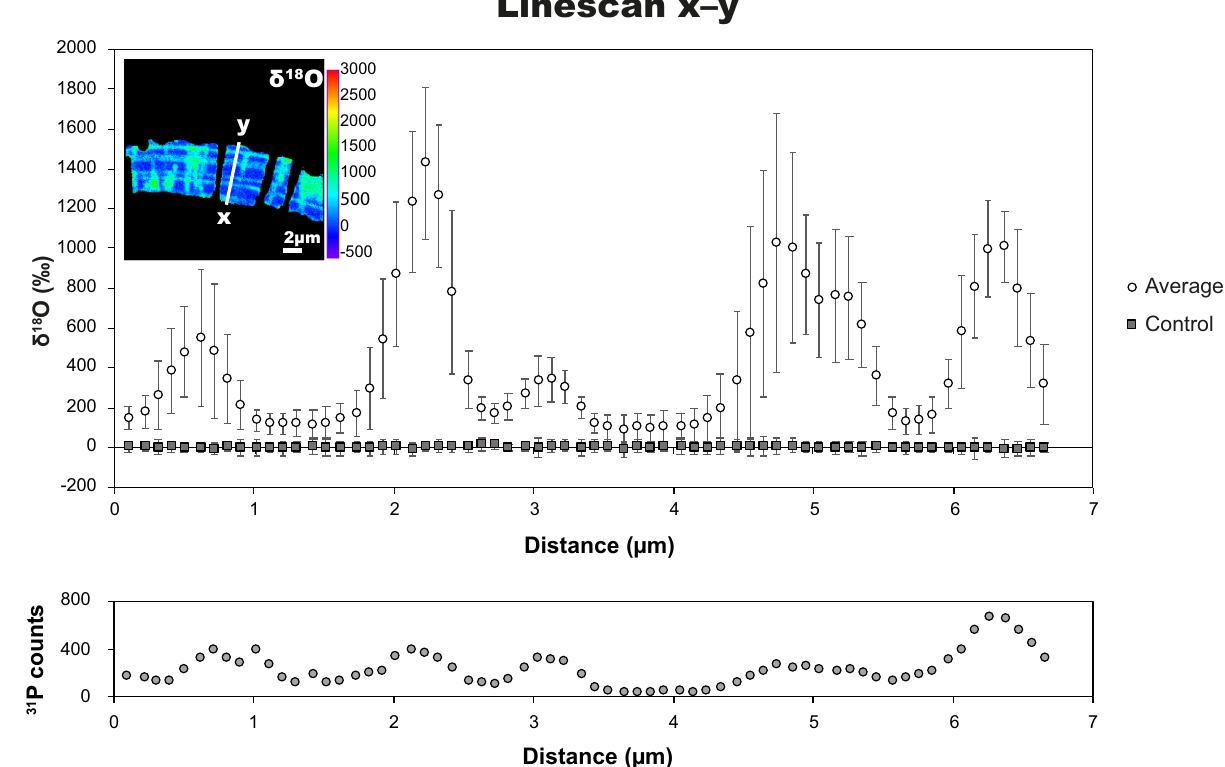
Fig. 5 18 O-enrichments in test walls between organic linings and cogwheel interfaces. Top: NanoSIMS line-scans across the width of a H. germanica test wall after incubation for 6 days at 90 °C in seawater analogue with a 18 O/ 16 O ratio of 0.30 (white circles), compared to a control sample with natural 18 O/ 16 O ratio (dark squares); error bars are 2 σ . NanoSIMS image inset shows the location of the line going from x to y . Bottom: corresponding 31 P-counts over the same line-scan indicating the location of organic